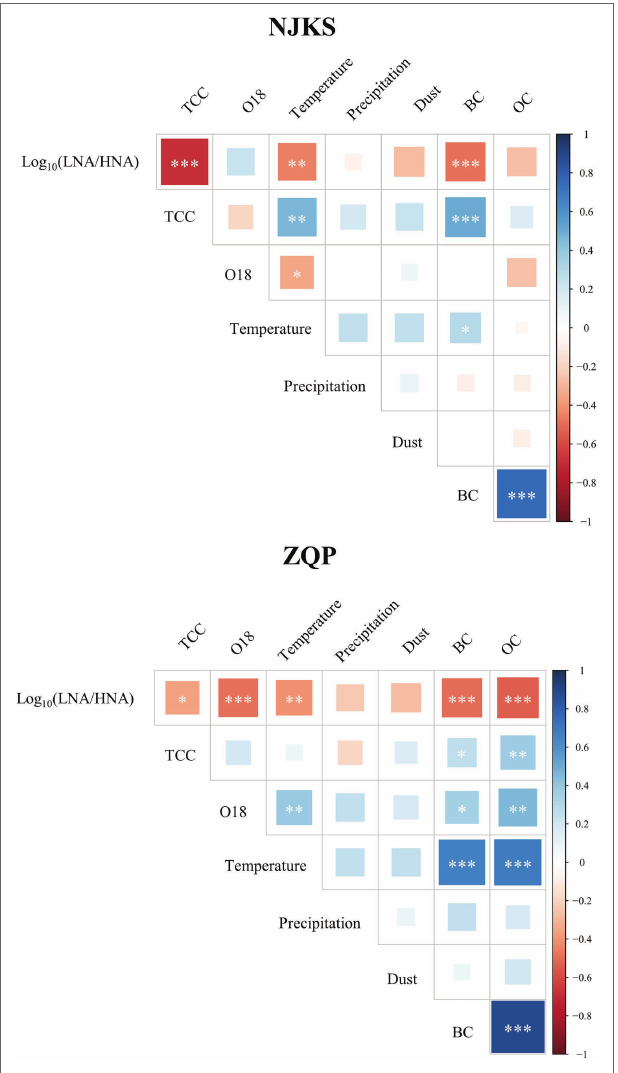
FIGURE 3 | Heatmaps showed the correlation of abiotic and biotic variables in NJKS and ZQP. Correlation coefficient denoted as p < .05 ( * ), p < .01 ( ** ), and p < .001 ( ***